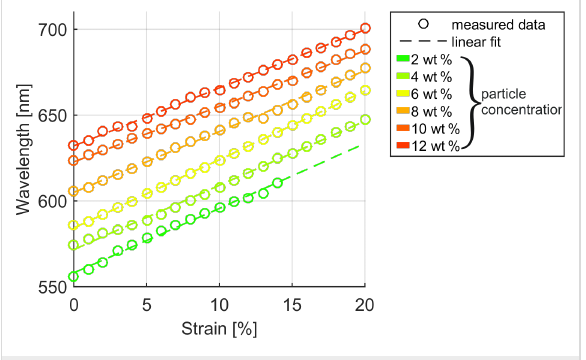
Figure 3: The shift of the resonance wavelength for 6 different sam- ples with particle concentrations in the dilution from 2 to 12 wt % are shown for 0 to 20% strain. All resonance wavelengths rise for increas- ing particle concentration and increasing strain.